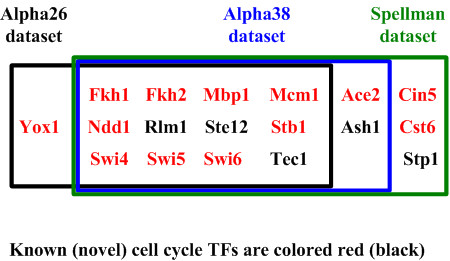
The results of using different cell cycle gene expression datasets. Our method identified 12, 14, and 17 cell cycle TFs using Pramila et al.'s alpha26 dataset, Pramila et al.'s alpha38 dataset, and Spellman et al.'s dataset, respectively. We found that among the 17 cell cycle TFs identified using Spellman et al.'s dataset, 14 TFs are also identified using Pramila et al.'s alpha38 dataset, and 12 TFs are also identified using Pramila et al.'s alpha26 dataset. This suggests that our method is robust against different cell cycle gene expression datasets.